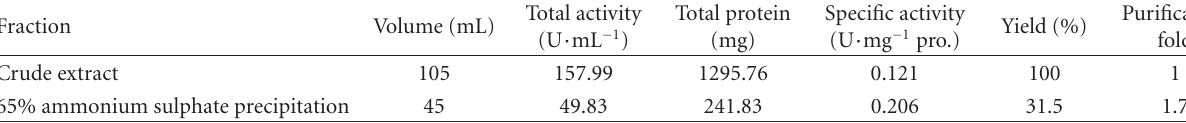
Table 1: Summary of the partial purification of rainbow trout liver rhodanese.